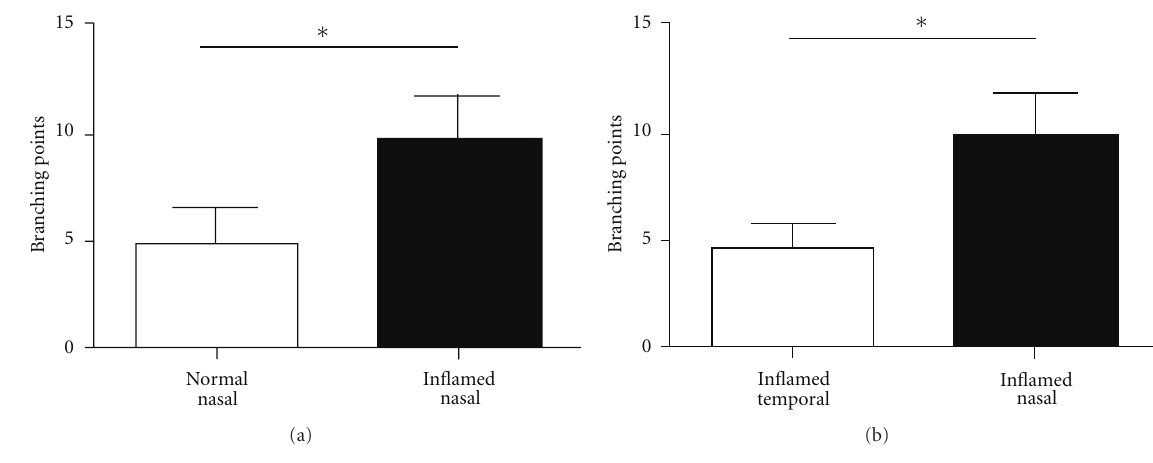
Figure 5: Comparison of branching points in conjunctival lymphatic vessels. (a) Significant di ff erence was found between conjunctival lymphatic vessels under the normal and inflamed conditions at the nasal side ∗ P < 0 . 05. (b) Significant di ff erence was found in conjunctival lymphatic branching points in the nasal versus temporal side under the inflamed condition. ∗ P < 0 .